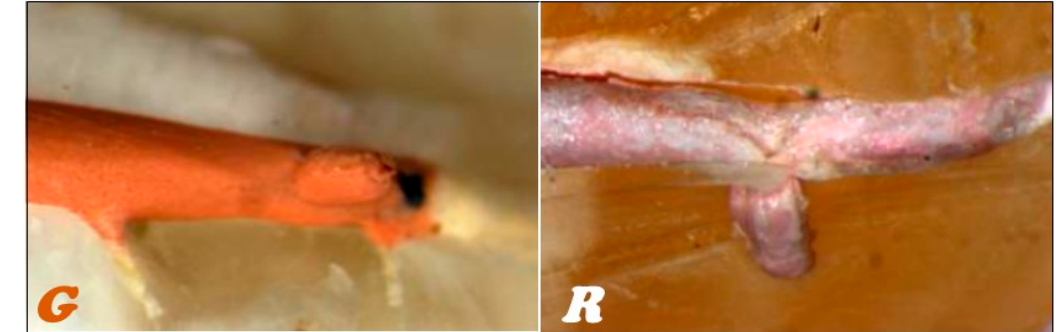
Figure 26. Lateral tubules in the apical part of the root canal filled with THC hot thermoplastic condensation ( G ) filled with a sealant and partially filled with material based on gutta ‐ percha and ( R ) and sealant ‐ coated resilon; LSM.